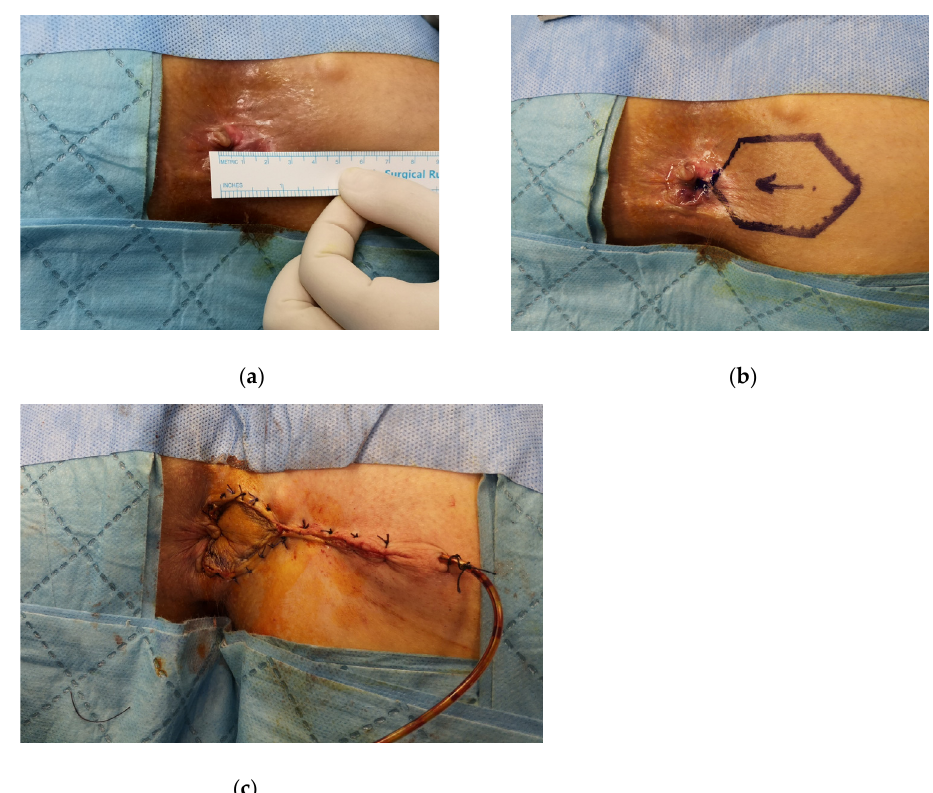
Figure 3. The diamond flap anoplasty is shown in a patient with severe anal stenosis, ( a ) the anal caliber is measured as 10 mm, ( b ) the right-sided anoplasty is decided according to the location of scar tissue in the anal verge, ( c ) the anoplasty is performed and the negative pressure drain is placed.